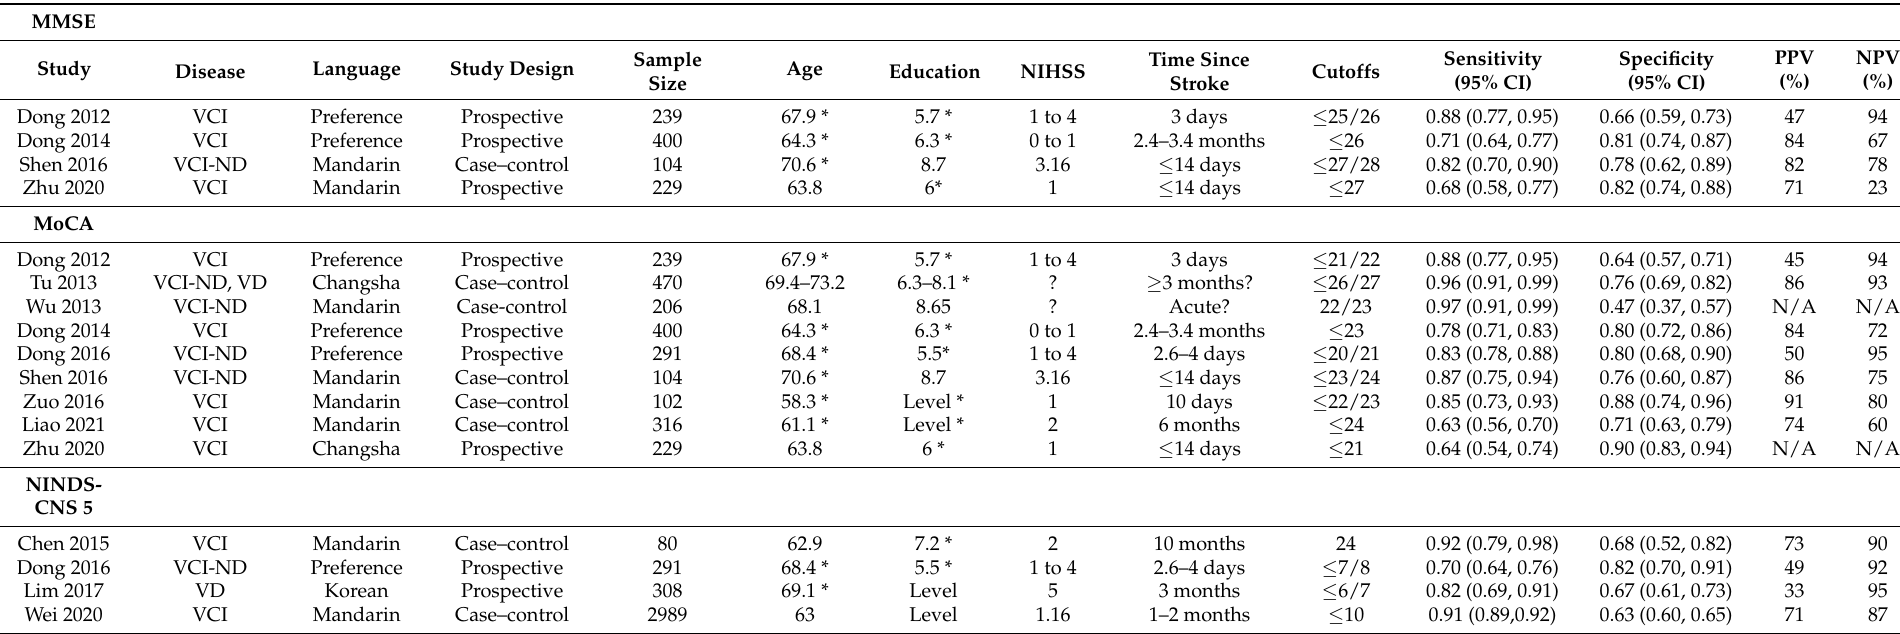
Table 1. Summary of studies and covariates categorized by